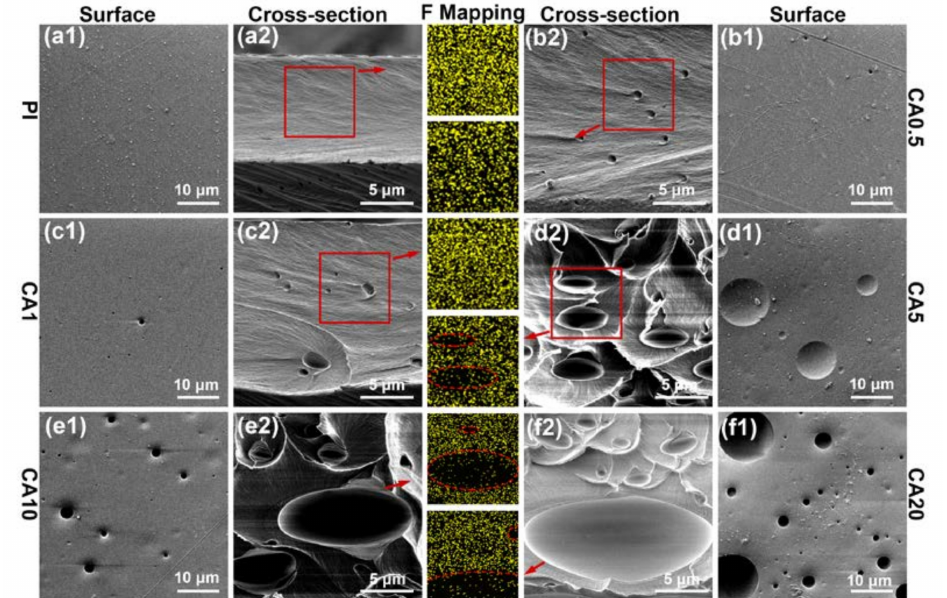
Figure 7. SEM images of heat-treating membranes: ( a 1– f 1) and ( a 2– f 2) are surface and cross section of PI, CA0.5, CA1, CA5, CA10, CA20 membranes, respectively. The middle images are selected area EDXS maps (F single: